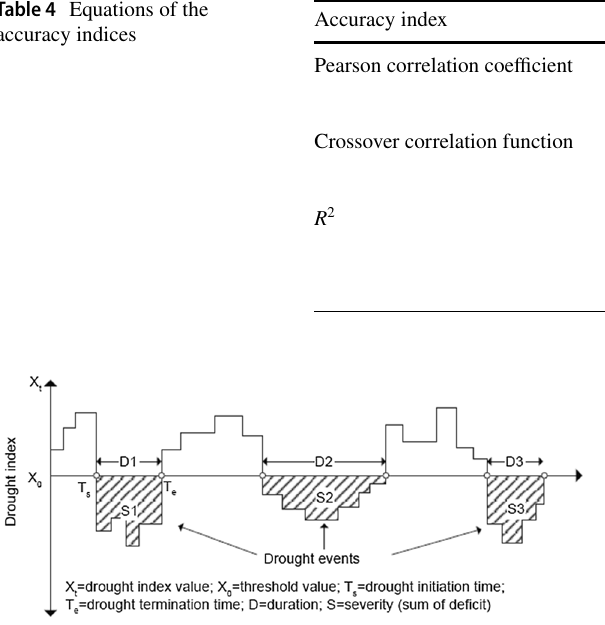
Fig. 2 Definition of drought characteristics including duration and magnitude using the run theory (Yevjevich 1967)